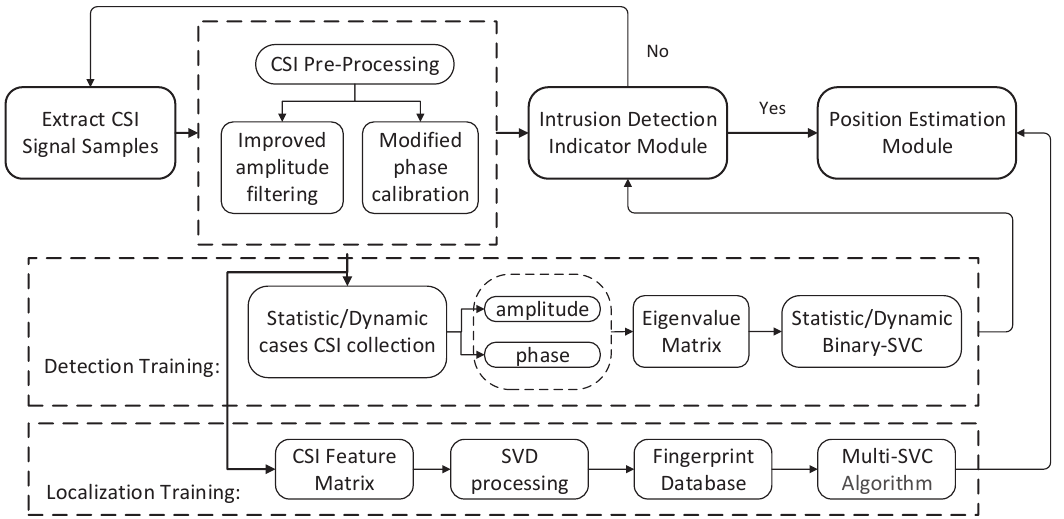
Figure 10. System architecture of C-InP .